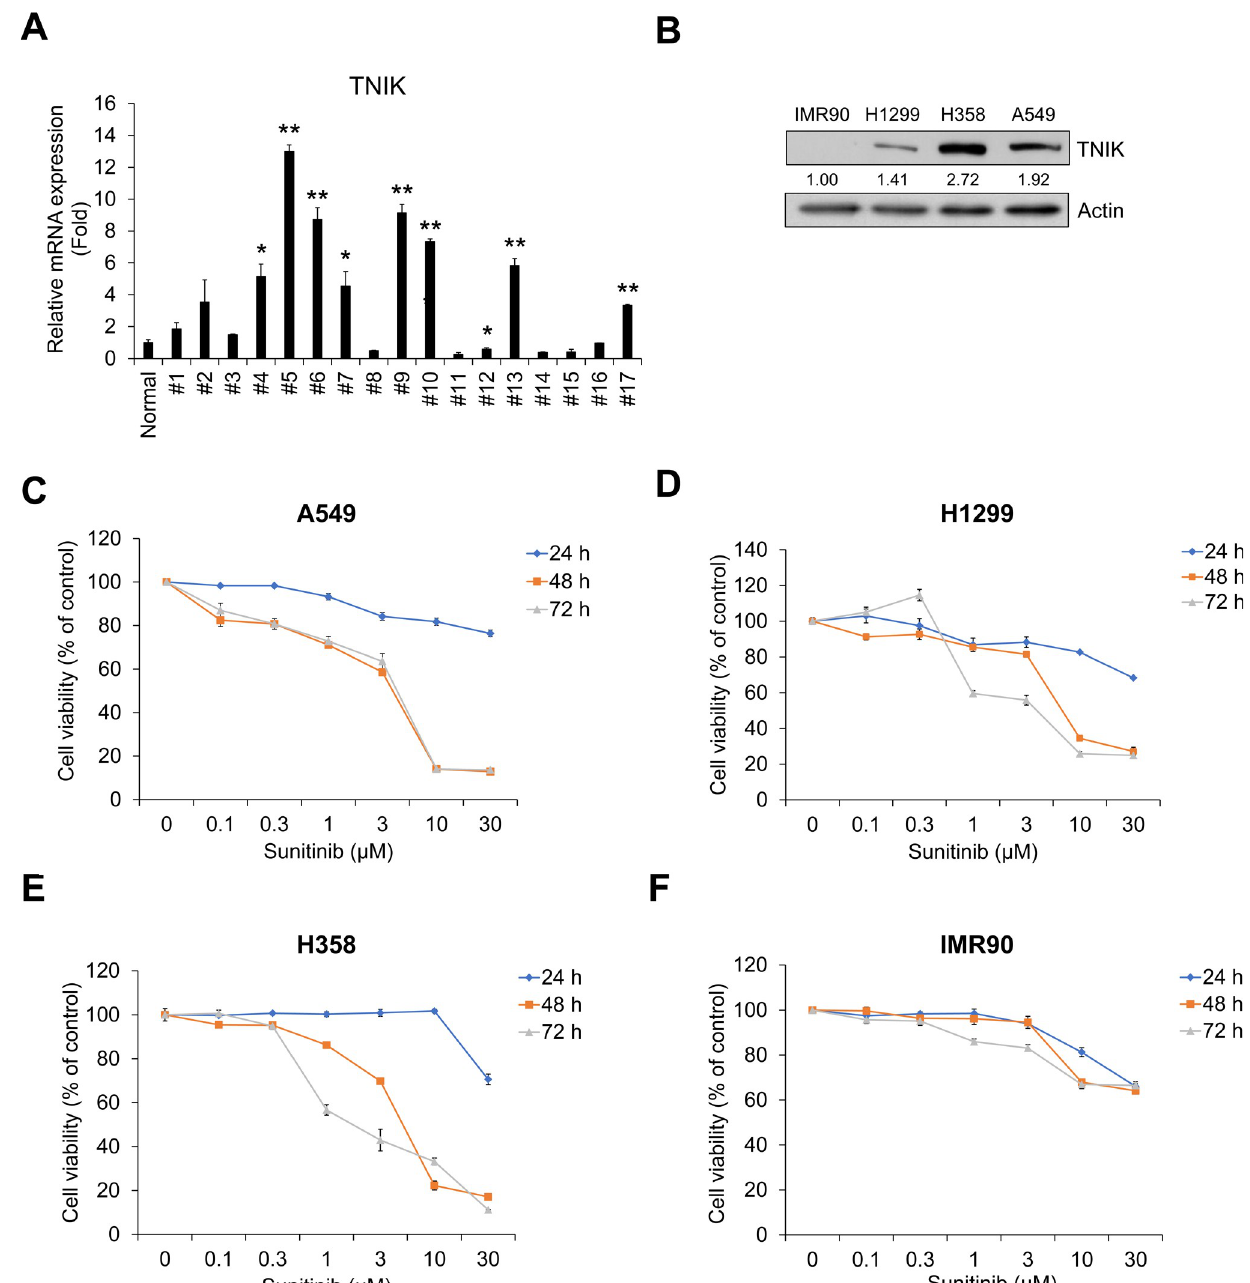
Fig 2. Sunitinib inhibits the proliferation of TNIK-expressing human NSCLC cells. (A) TNIK mRNA expression in NSCLC tissue cells from lung cancer patients. TNIK mRNA expression levels were measured by qRT-PCR analysis in pool normal lung tissue cells (n = 8) and in NSCLC cells from patients with lung cancer (n = 17). The normal group represents the average qRT-PCR results obtained from eight healthy lung tissue cells without cancer cells. Data represent the mean ± SD of raw results. Experiments were performed in triplicate. � p < 0.05 and �� p < 0.001 (vs. control). (B) The protein expression of TNIK in normal fibroblast IMR90 and NSCLC H1299, H358, and A549 cells was measured by Western blot. Actin was used as a loading control. A549 (C), H1299 (D), and H358 (E) cells and IMR90 (F) cells were treated with sunitinib for 24–72 h. After incubation, cell viability was measured by CCK-8 assay. Experiments were performed in triplicate. Data represent the mean ± SD of raw results.